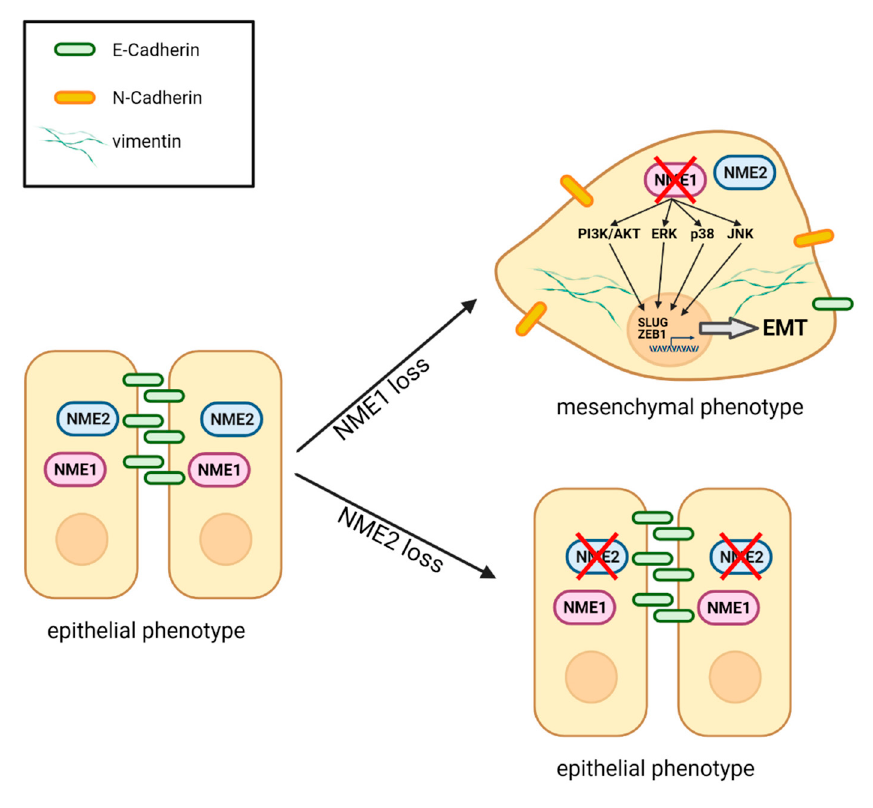
Figure 10. Schematic representation of the effects of loss of NME1 or NME2 on EMT. When NME1 is lost from epithelial cells, the PI3K/AKT, ERK, p38 and JNK pro-EMT signaling pathways are activated. This leads to expression of two key EMT transcription factors SLUG and ZEB1 and launches a partial EMT. The cells lose most E-cadherin from the surface, while they gain N-cadherin on the surface and vimentin in the cytosol. They adopt a more mesenchymal morphology and they lose attachment to neighboring cells. When NME2 is lost, by contrast, there is no effect on the epithelial state of the cells. Figure created with BioRender.com.